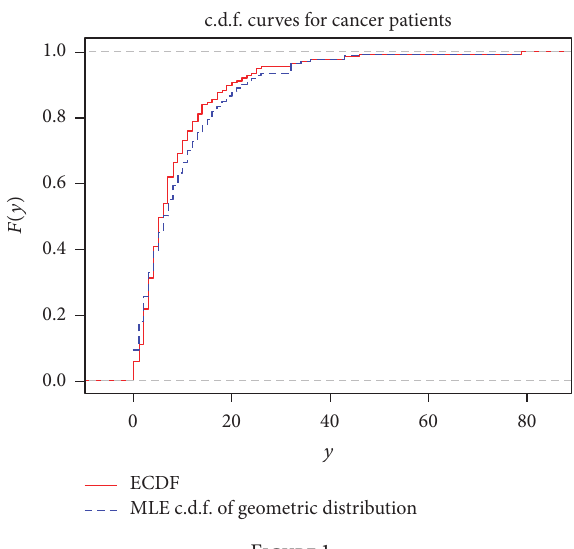
ECDF MLE c.d.f. of